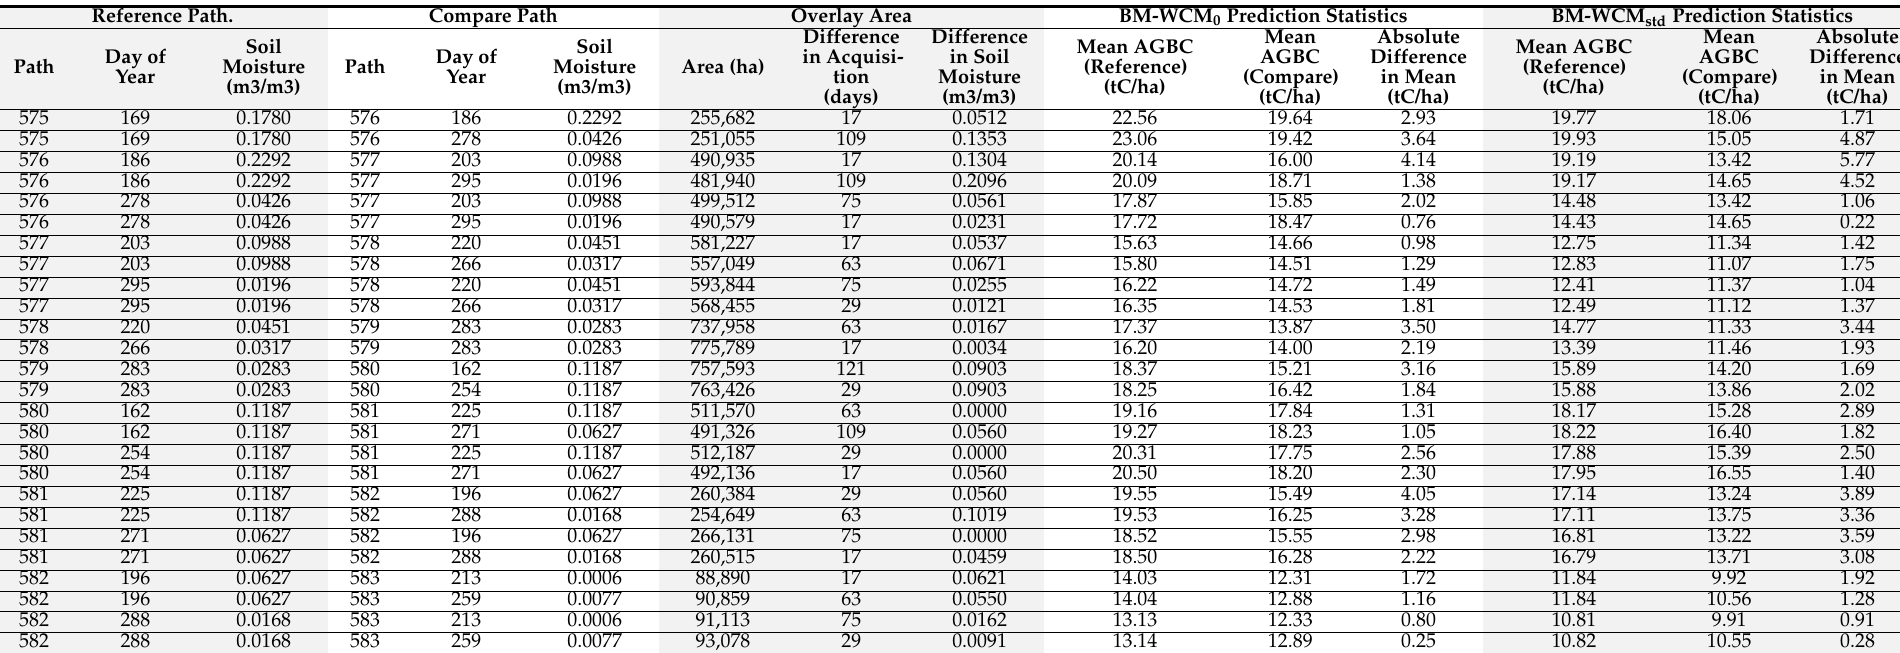
Table A3. Statistics for each compared overlay area in the AGBC mosaics including the path, acquisition dates, soil moisture, and predicted AGBC from BM- WCM 0 and BM-WCM std for the reference and compared paths with differences in acquisition dates, soil moisture, predicted AGBC, and predicted area for the overlay